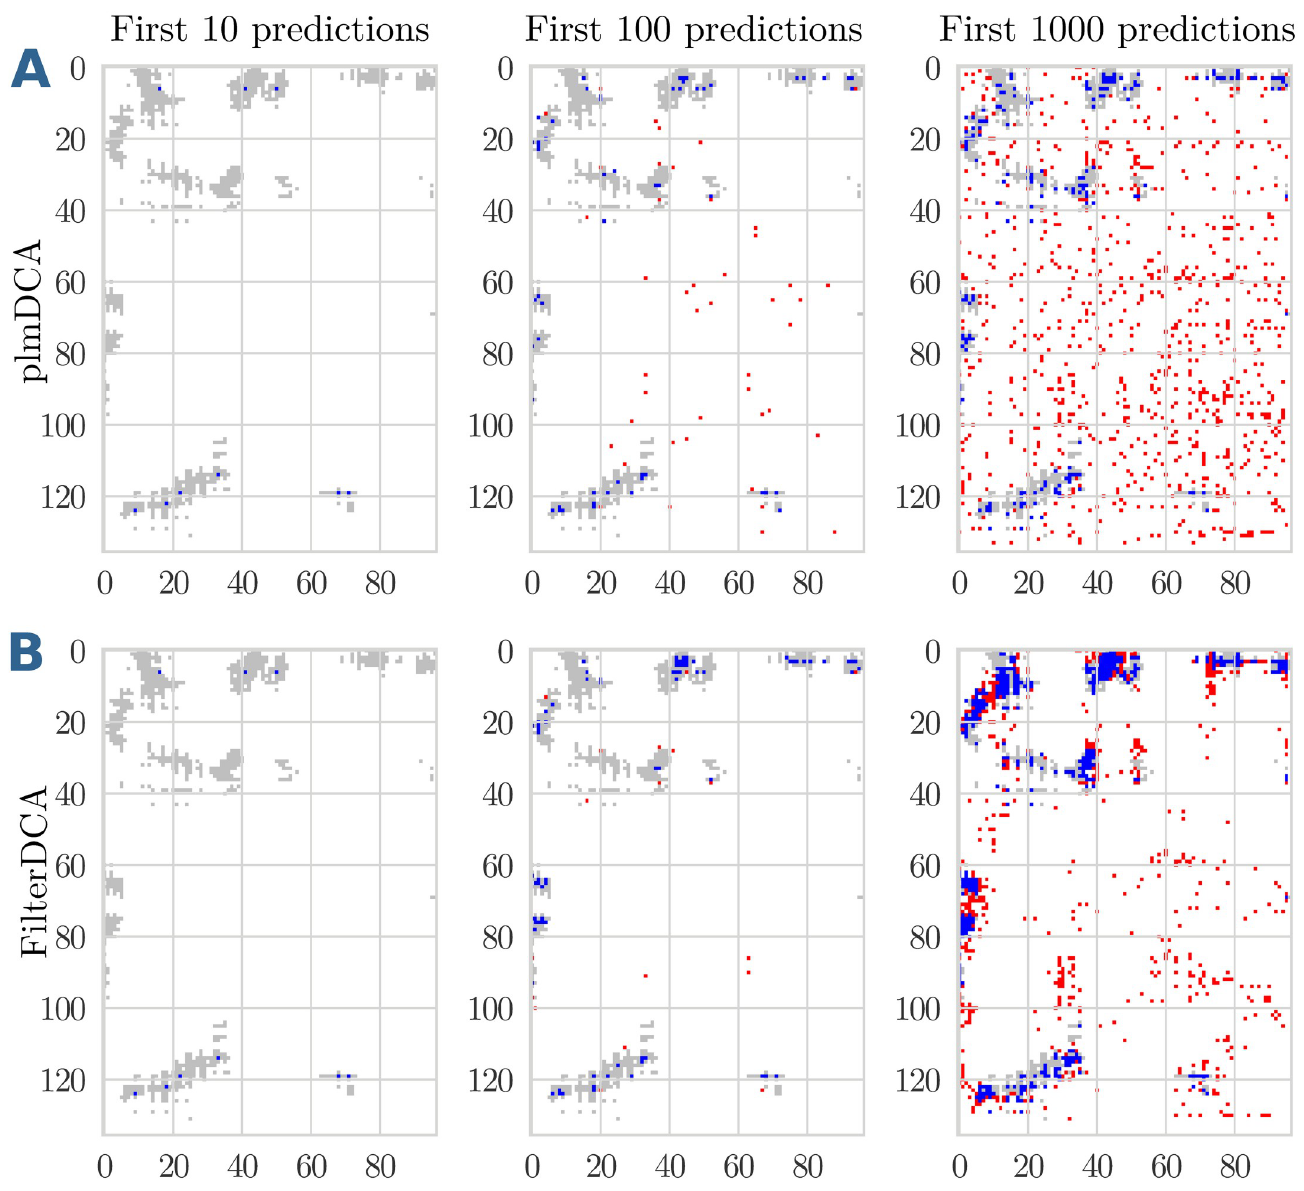
Fig 6. Contact map prediction for the interaction between the domain families PF02773 and PF00438 co-occurring in S-adenosylmethionine synthetases. The upper panels (A) show the predictions of plmDCA, the lower panels (B) those of FilterDCA, for the first 10, 100 or 1000 predicted contacts. In each figure, the native contacts are shown in grey, TP predictions of the two methods in blue, FP predictions in red. This example shows a case where plmDCA detects some signal, which is subsequently cleaned by FilterDCA.